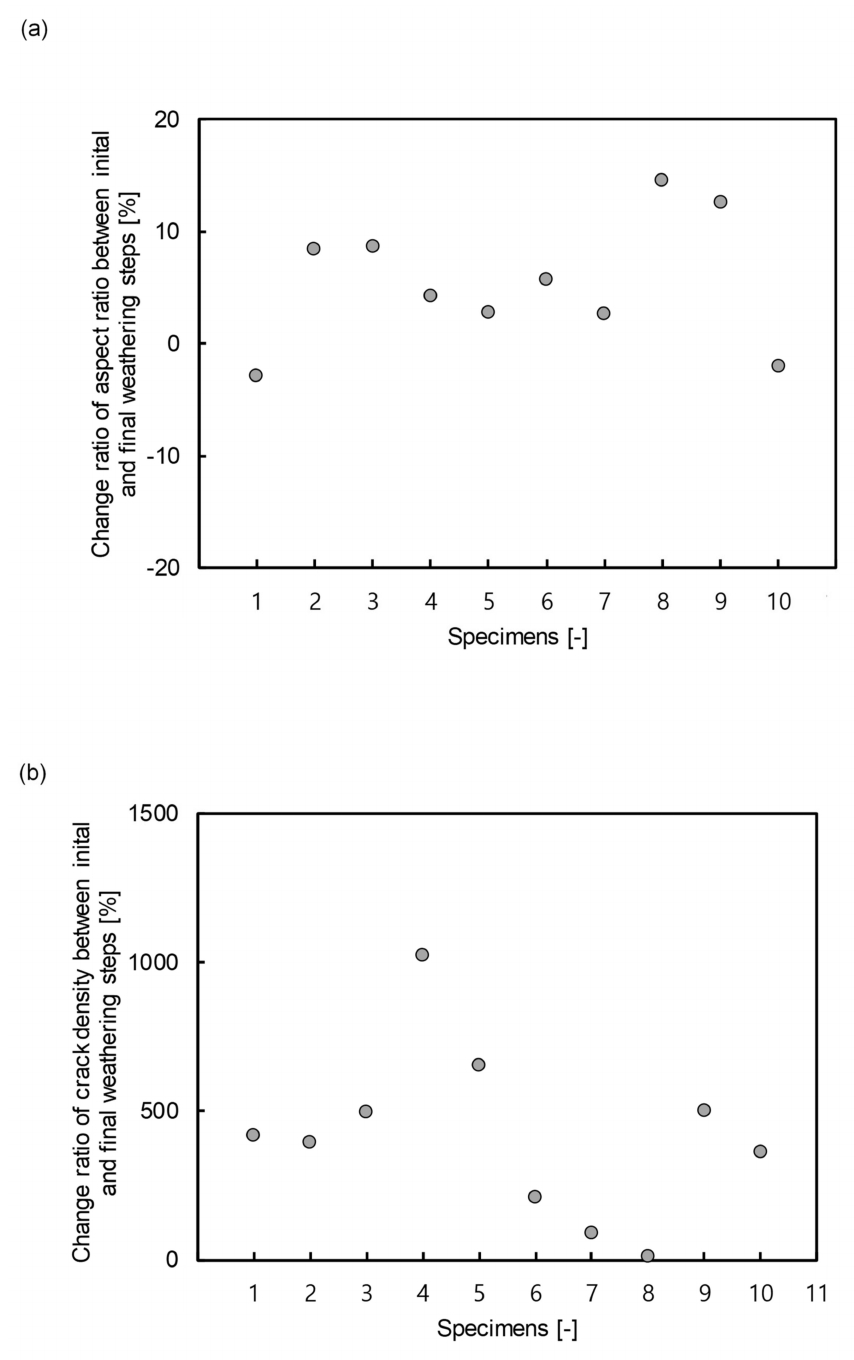
Figure 10. Change ratios for ( a ) aspect ratio and ( b ) crack density. The 1, 2, 3, 4, 5, 6, 7, 8, 9, and 10 denote samples albite 1, albite 2, albite 3, albite 4, quartz 1, quartz 2, quartz 3, biotite, calcite, and chlorite,